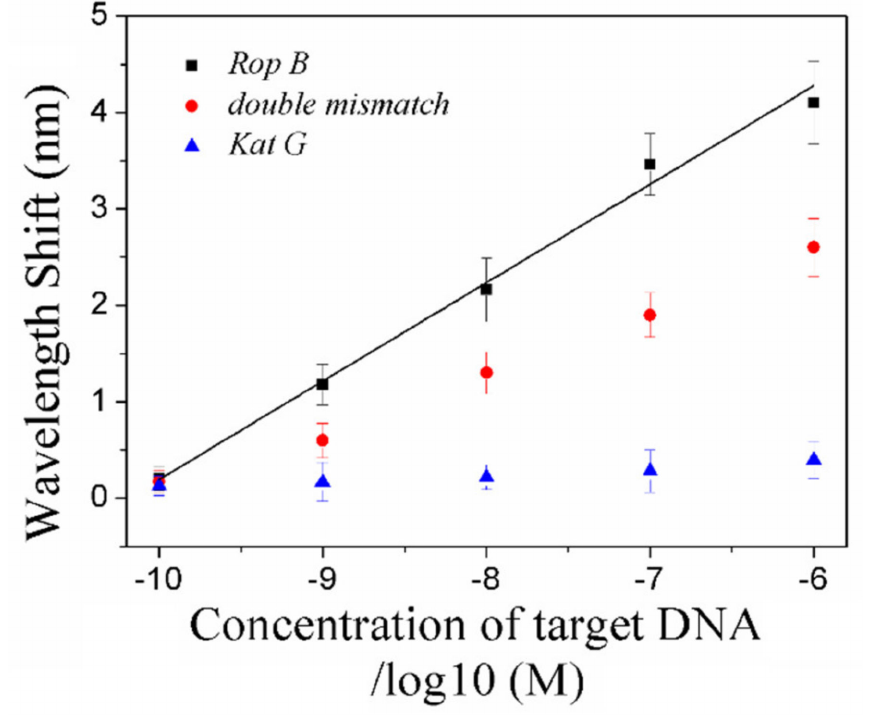
Figure 7. The LSPR wavelength shifts and linear calibration curve after AuNP/DNA amplification for various concentrations of rop B ssDNA. The wavelength shifts of double mismatch rop B ssDNA and kat G ssDNA are also shown for negative